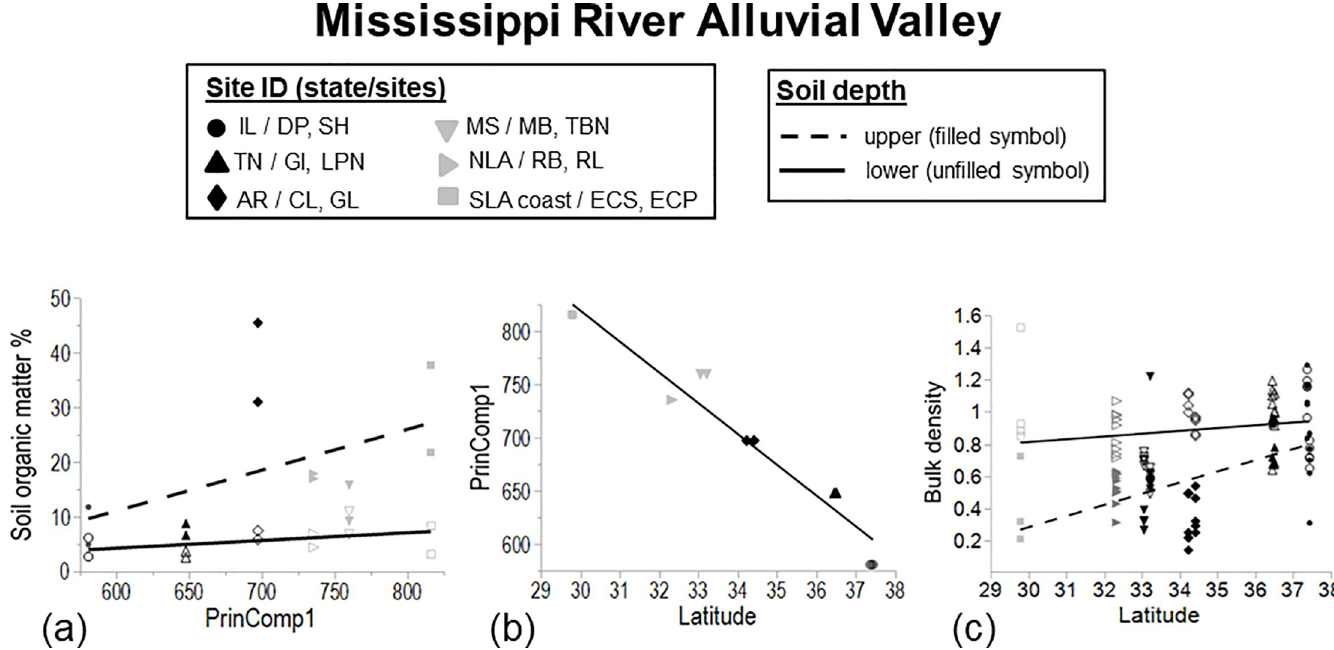
Fig 5. Relationship of (a) upper and lower soil depths (0–30 vs. 30–100 cm; dashed and solid line, respectively; S6 Table) to soil organic matter % vs. PrinComp1, (b) PrinComp1 to latitude (r 2 = 0.937, p < 0.0001), and (c) upper and lower soil depths to bulk density by latitude (r 2 = 0.303, p < 0.0001) (S5 Table). PrinComp1 is based on the equation: principal component 1 = (normal annual precipitation � 0. 0.494947) + (normal maximum temperature � 0.502801) + (normal minimum temperature � 0.497784) + (normal mean temperature � 0.504410). Whole model fit (MRAV only) for the organic matter % (arcsine square root transformed) was r 2 = 0.791, F = 30.1, p < 0.0001. Regressions models were prepared only for those climatic and environmental variables identified as significant by PROC GLMSELECT (VIF < 10; S6 Table). Note that Cat Island NWR was not sampled in this survey. https://doi.org/10.1371/journal.pone.0226998.g005 PLOS ONE | https://doi.org/10.1371/journal.pone.0226998 January 3,